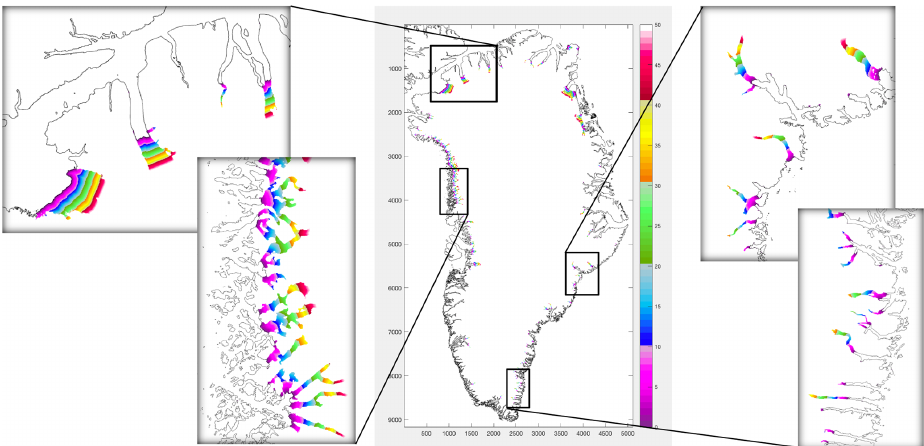
Figure D1. Distances from the ocean for all points identified as ice grounded on bed below sea level in potential contact with the ocean. The data are masked to areas less than 50km from the nearest grounding line.